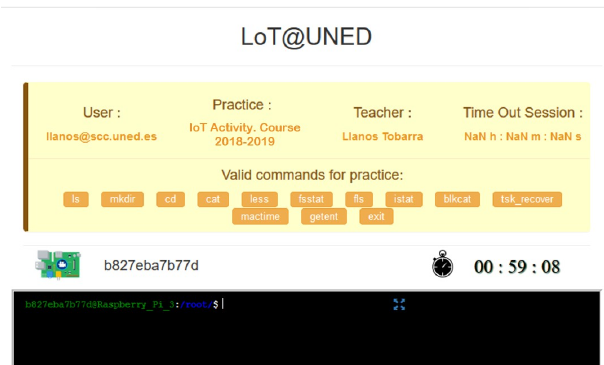
Figure 7. Interaction with IoT devices using the Shell service in